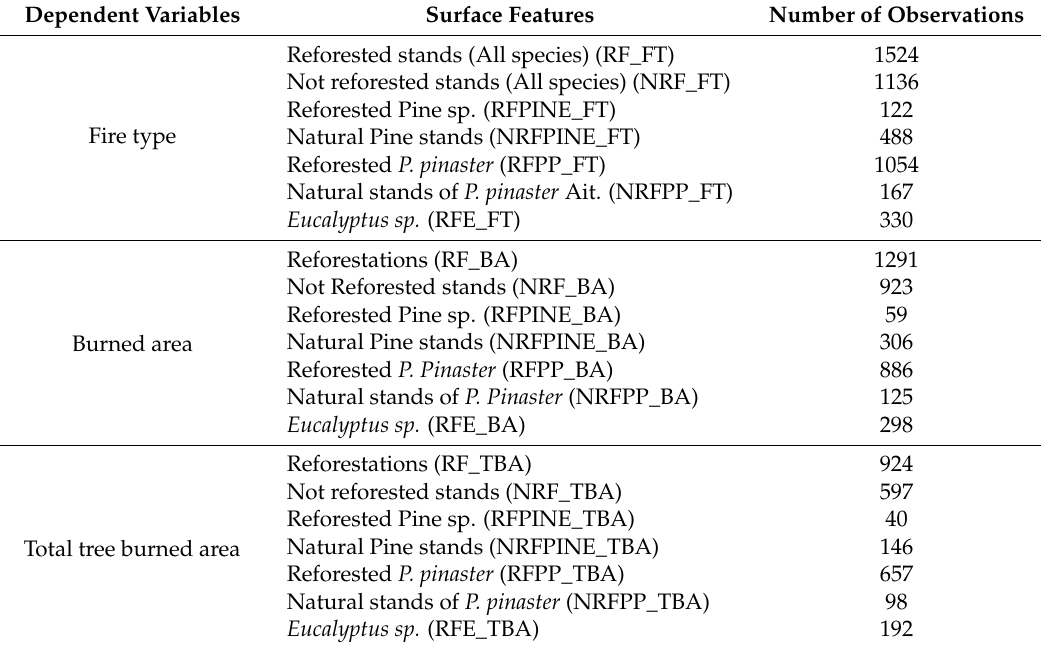
Table 2. Database definition and number of fire observations used for model